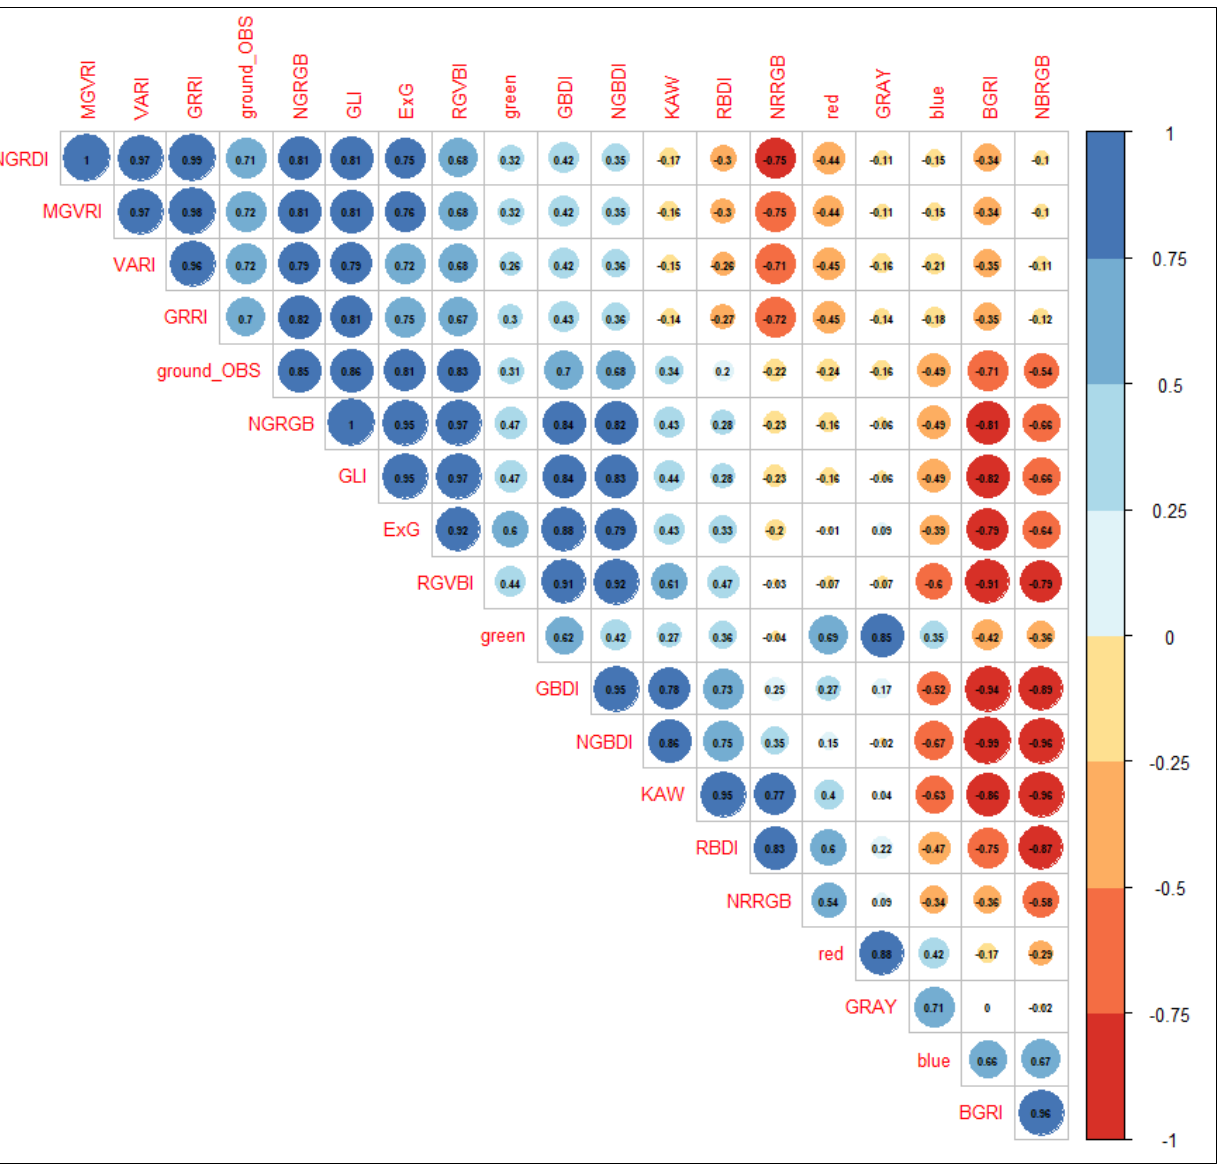
Figure A3. Correlogram of the Pearson correlation between vegetation indices and ground leaf phenology observations. The numbers and the color gradient scale reveal the Pearson correlation value, and the size of the circle indicates the significance of the probability of the null hypothesis.